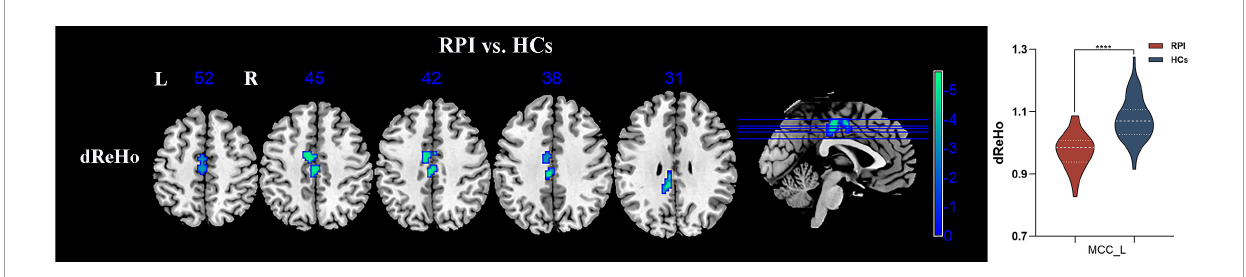
FIGURE3 sReHo/dReHo differences between pontine infarction (PI) and healthy controls (HCs) group. Voxel-based analysis showed brain regions with significant dReHo alterations of RPI group. dReHo, dynamic regional homogeneity; RPI, right pontine infarction; sReHo, static regional homogeneity. ****Represents p -value < 0.0001.